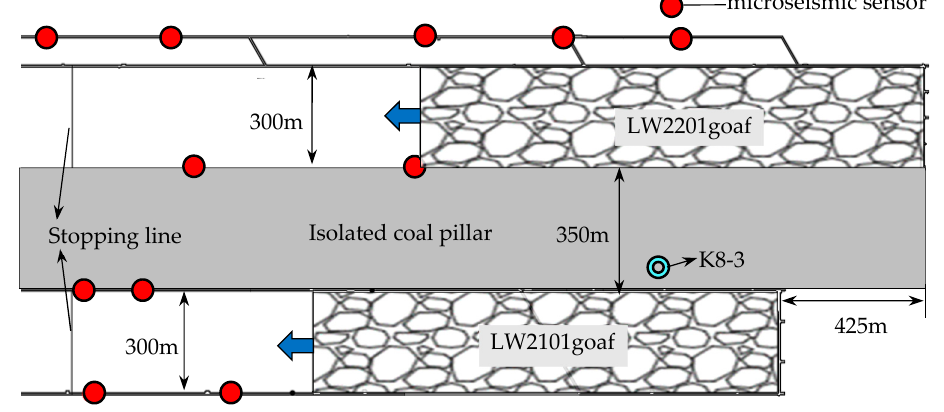
Figure 3. ICP and layout of working faces on both sides.